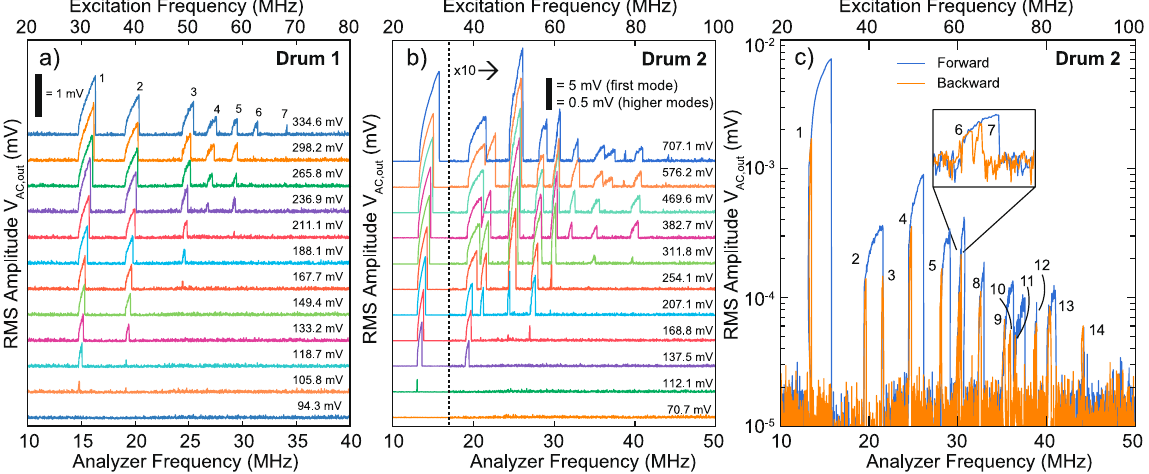
Figure 2. Multi-mode response of a parametrically driven graphene resonators. ( a ) Waterfall plot of the multimode response at different driving amplitudes. Each mode appears at different driving levels due to variations in quality factor and effective driving force between them. The scale bar indicates the root mean square value (RMS) of V ac,out and the labels on the right indicate the RMS driving amplitude V ac,in . ( b ) Waterfall plot for a different drum, showing more mechanical modes and modal interactions. ( c ) Forward and backward frequency sweep at the highest parametric driving amplitude for the drum in ( b ) revealing 14 distinct mechanical modes in parametric resonance.